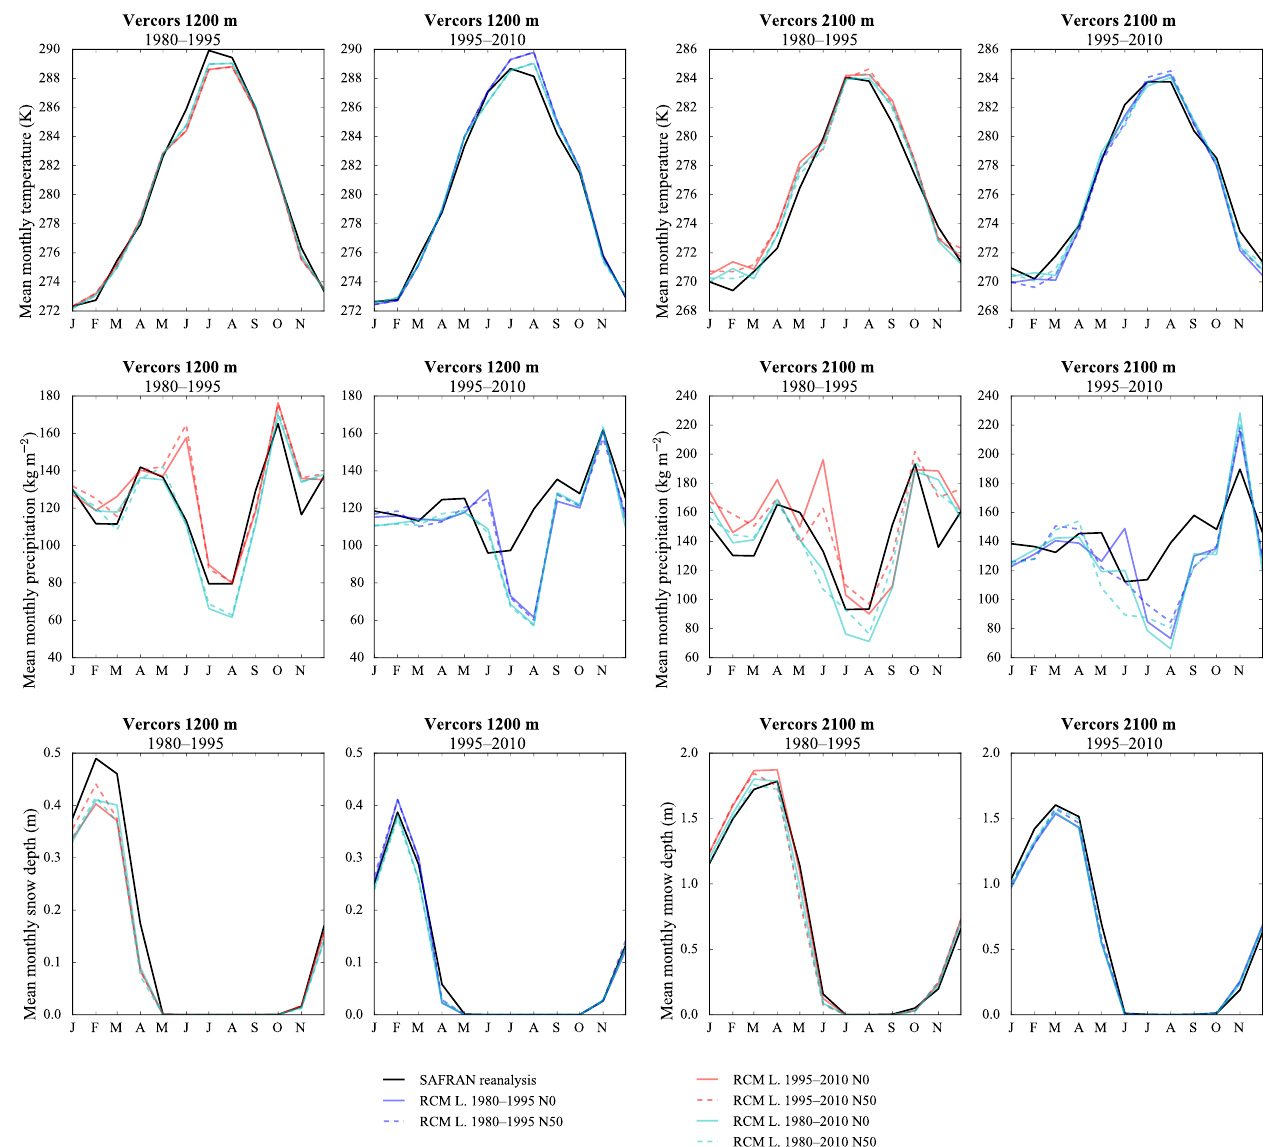
Figure 11. Mean annual cycle of temperature, precipitation and snow depth (using Crocus in this case) in each adjusted RCM simulation and in the SAFRAN reanalysis over the periods 1980–1995 and 1995–2010 for the Vercors massif at 1200 and 2100ma . s . l . Letters on the x axis correspond to the different months of the calendar (J = January, F = February,